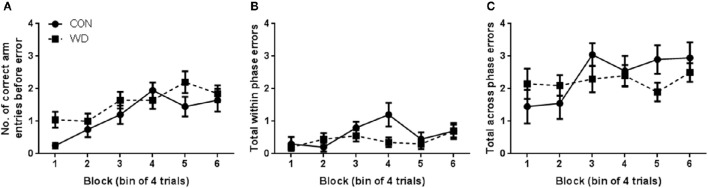
Performance in test phase of DWSh task. (A) Number of correct arm choices before error in each session of training. (B) Total number of within phase errors in each session of training. (C) Number of across phase errors in each session of training. n = 10 per group.